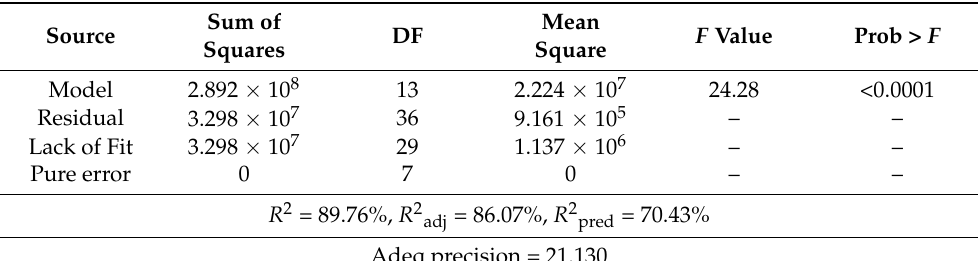
Table 6. Reliability analysis result of the simplified quadratic regression equation.